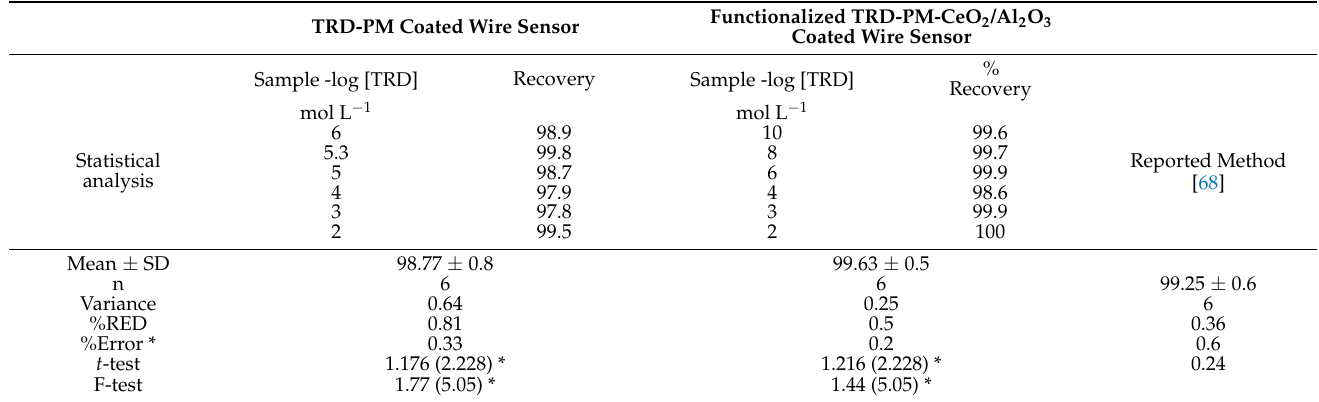
Table 6. The obtained results of the determination of TRD in its commercial capsules (50 mg/capsule) using conventional and functionalized TRD-PM and TRD-PM-CeO 2 /Al 2 O 3 nanocomposite coated wire